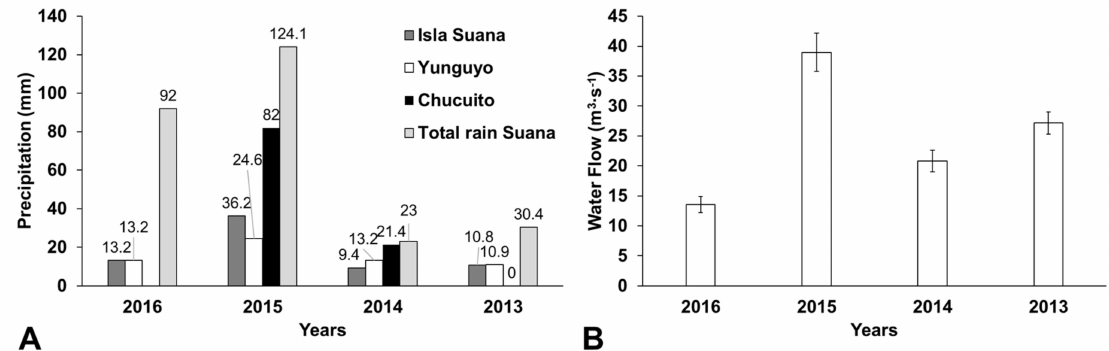
Figure 3. ( A ) Precipitation from maximum continuous rain events registered at three different locations around the Lago Menor (Figure S3) and total precipitation during April of different years. ( B ) Average water flows recorded at the Desaguadero River (all data collected from Senamhi Peru web page